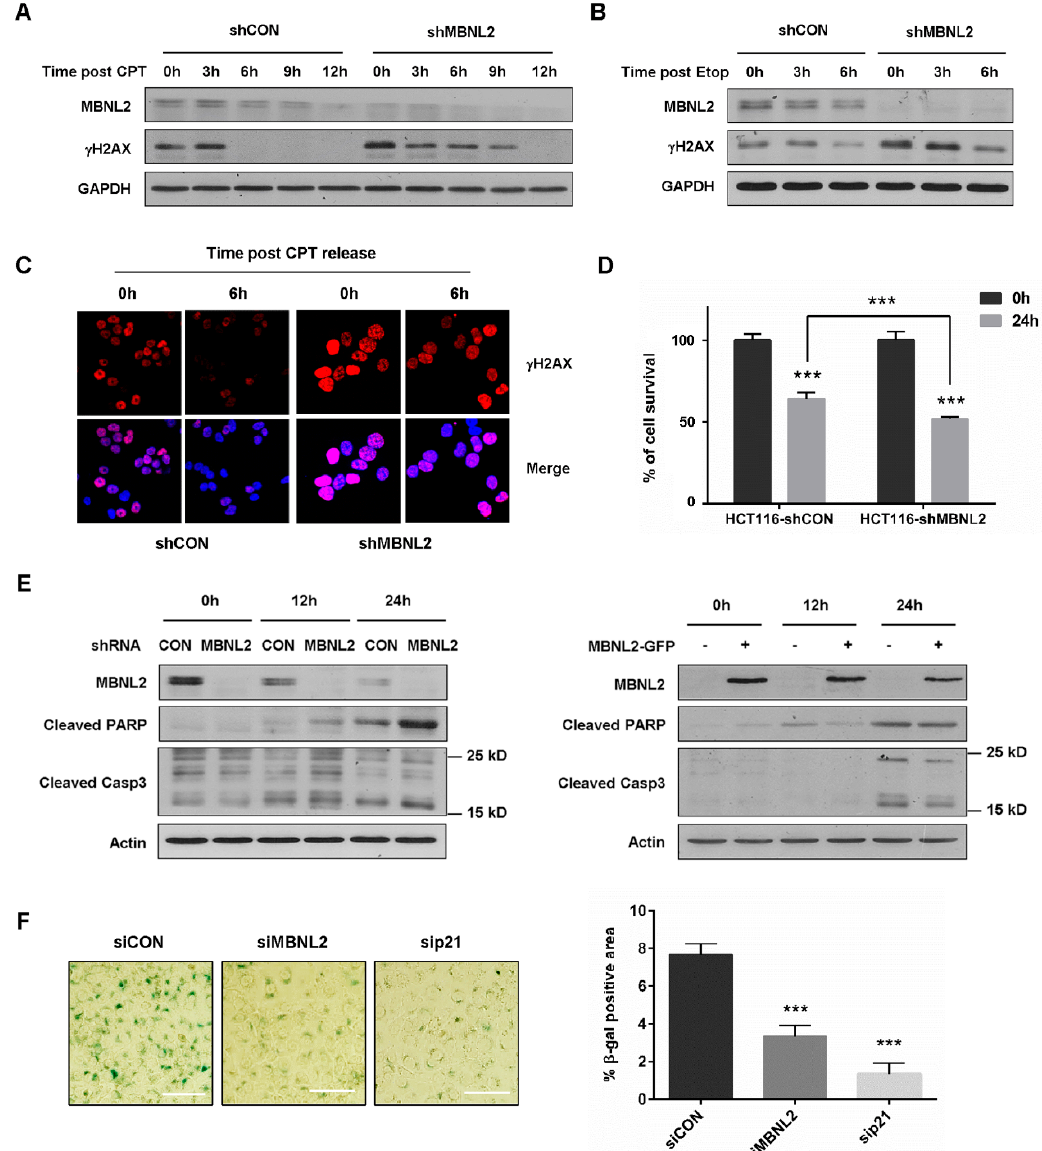
Figure 6. Depletion of MBNL2 impairs DNA damage repair and DNA damage-induced senescence but promotes DNA damage-induced apoptosis. ( A ) HCT116 cells transfected with control or MBNL2 shRNA lentiviral constructs were treated with 1 μ M CPT, ( B ) 10 μ M etoposide (Etop) for 12 h and released into a fresh medium for the indicated time. The samples were collected and subjected to immunoblotting analysis of γ H2AX. ( C ) Representative images of γ H2AX immunostaining in the HCT116 cells transfected with control or MBNL2 shRNA lentiviral constructs, treated with 1 μ M CPT for 12 h, and released into a fresh medium for the indicated time. ( D ) HCT116 cells transfected with control or MBNL2 shRNA lentiviral constructs were treated with 1 μ M CPT for 0 h or 24 h and the Cell Counting Kit-8 assay was performed to detect percentage of cell survival. ( E ) Immunoblotting of cleaved PARP and Caspase 3 in the HCT116 cells transfected with control or MBNL2 shRNA lentiviral constructs (left), empty vector, or MBNL2-GFP plasmids (right) and treated with 1 μ M CPT for 0, 12, or 24 h. ( F ) Representative images (left) of SA- β -galactosidase staining in the HCT116 cells transfected with control, MBNL2, p21 siRNA and treated with 20 nM CPT for 96 h. The percentage of SA- β -galactosidase-positive cells was quantified (right). *** p < 0.001.